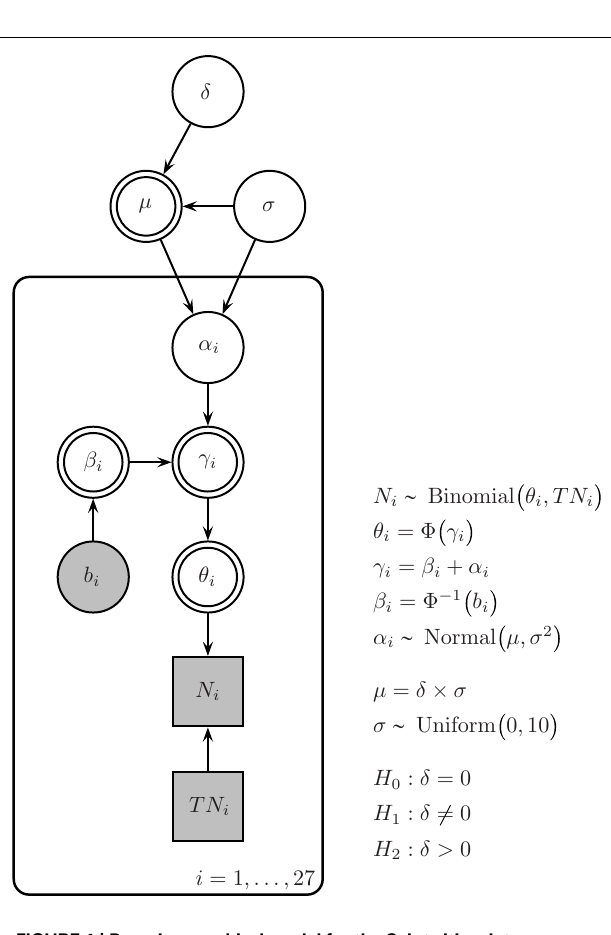
FIGURE 1 | Bayesian graphical model for the Saint cities data. Parameter